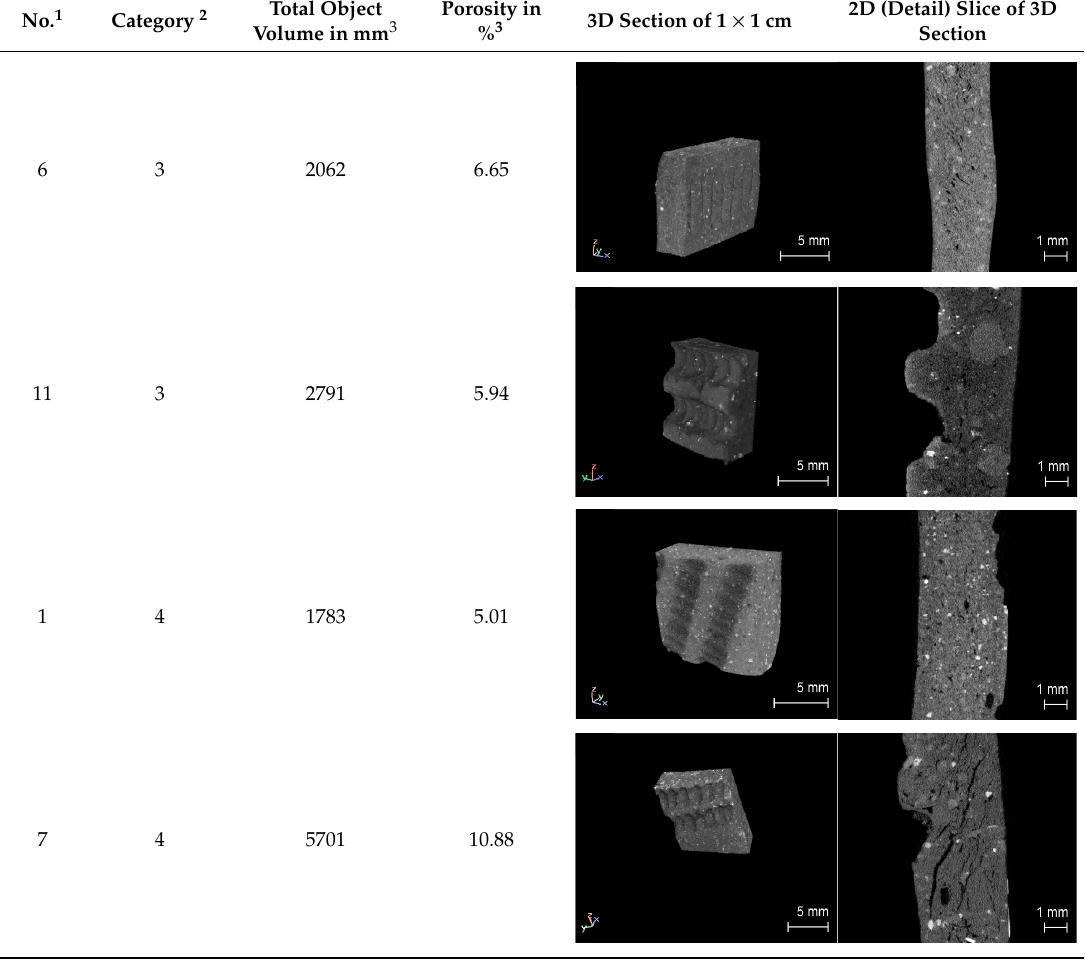
Table 5. X-ray microtomography scans of neolithic samples and morphometric information.